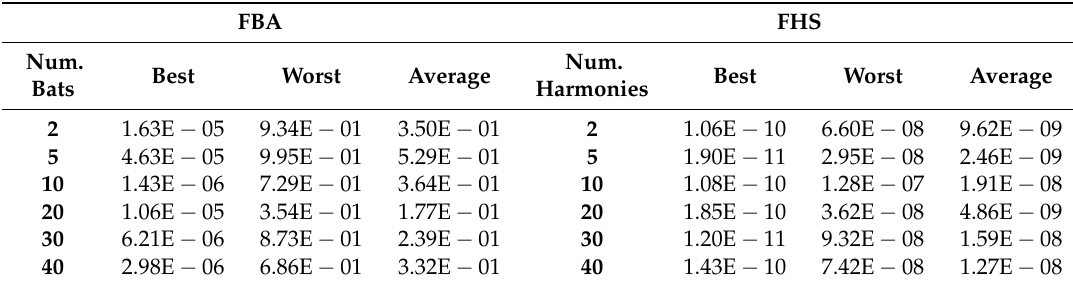
Table 17. Experiment results for the Rastrigin function with the FBA and FHS algorithms. FBA FHS Num.